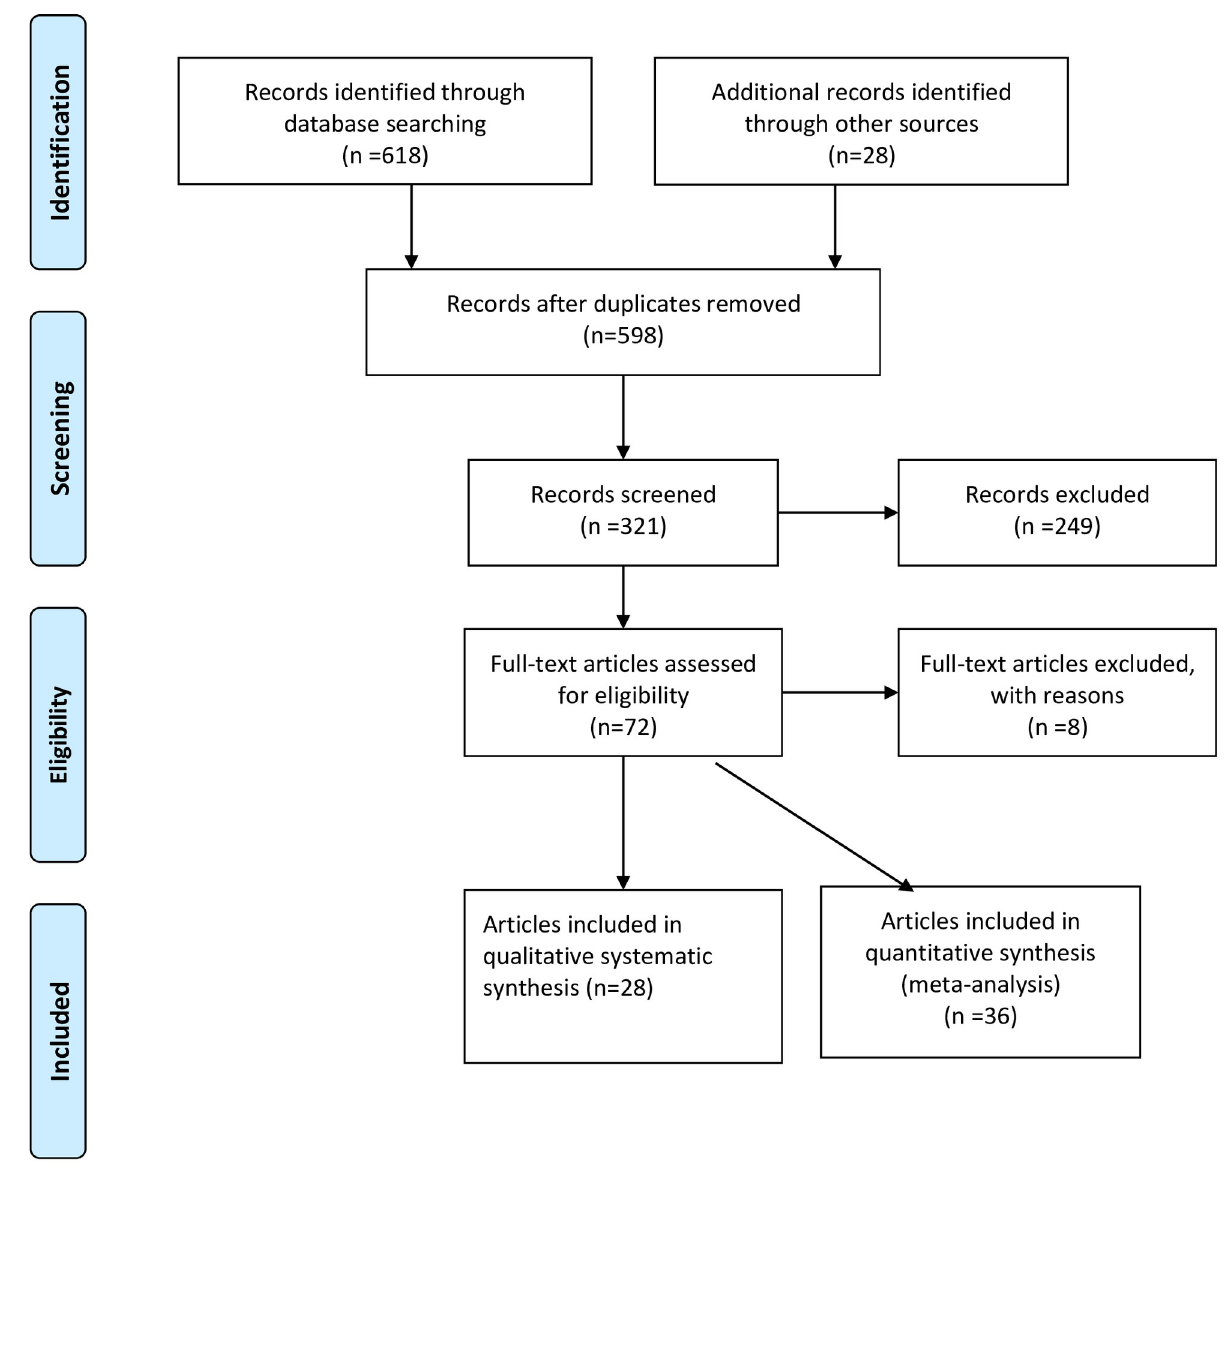
Fig 1. Flow diagram of manuscript retrieval and study selection.